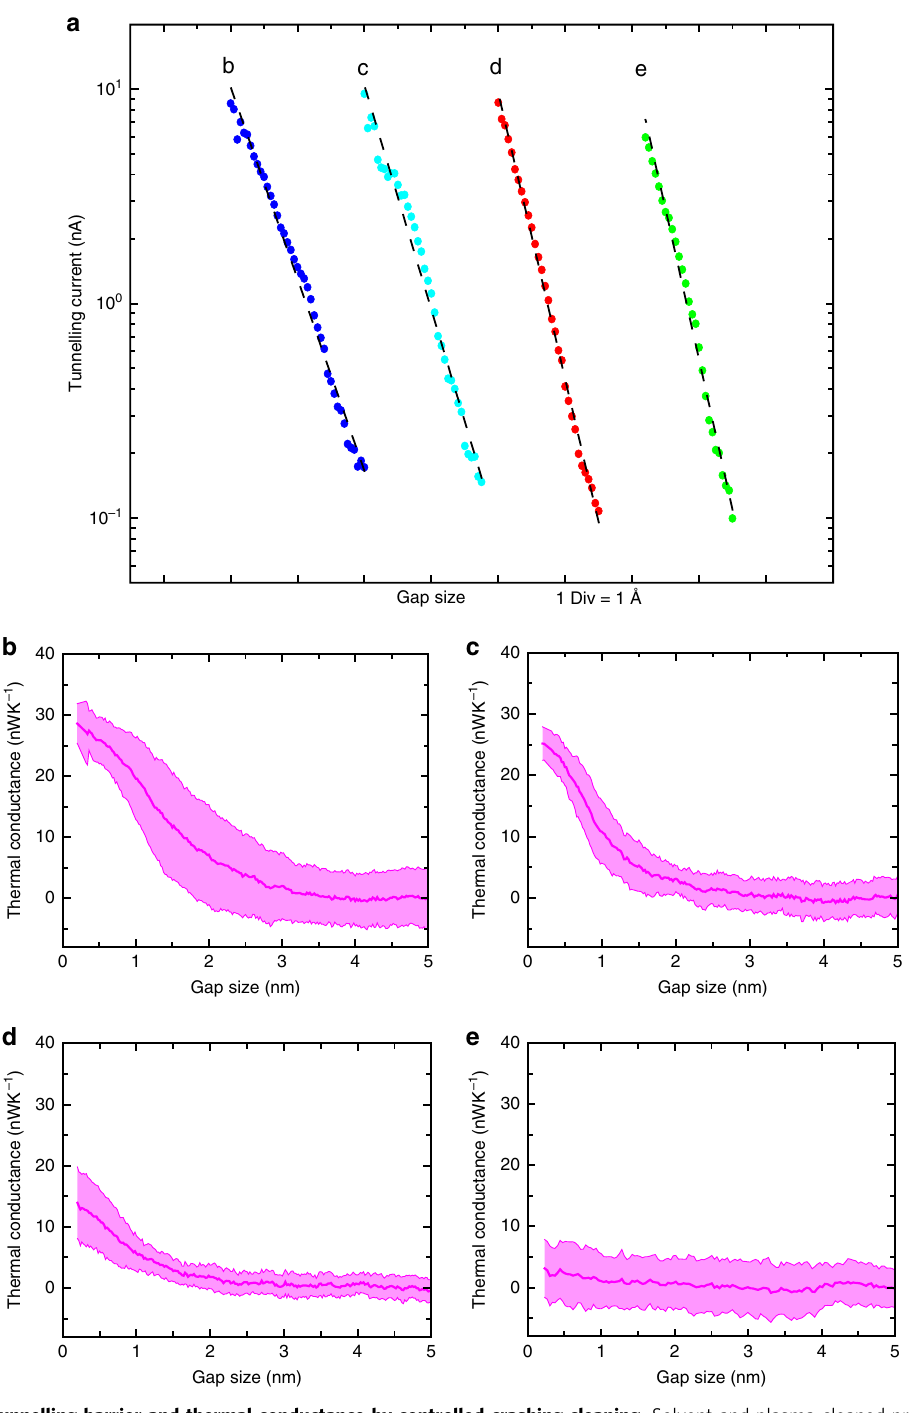
Figure 3 | Apparent tunnelling barrier and thermal conductance by controlled-crashing cleaning. Solvent and plasma-cleaned probes were used in experiments where the probe was intentionally indented into the substrate by a few nanometres to create a direct point contact between the probe and the sample. This procedure resulted in gaps that featured larger apparent tunnelling barrier heights. Specifically, j ap was found from tunnelling current versus displacement curves ( a ) to monotonically increase from 1eV (dark blue dots, for the probe in initial condition) to 1.4eV, to 2.2eV and finally to 2.5eV in consecutive experiments where the tip was displaced into the substrate by 1nm (light blue dots), 2nm (red dots) and 5nm (green dots), respectively. The thermal conductance corresponding to each of these scenarios is shown in b – e . It can be seen that the apparent near-field thermal conductance is systematically reduced as the apparent tunnelling barrier height